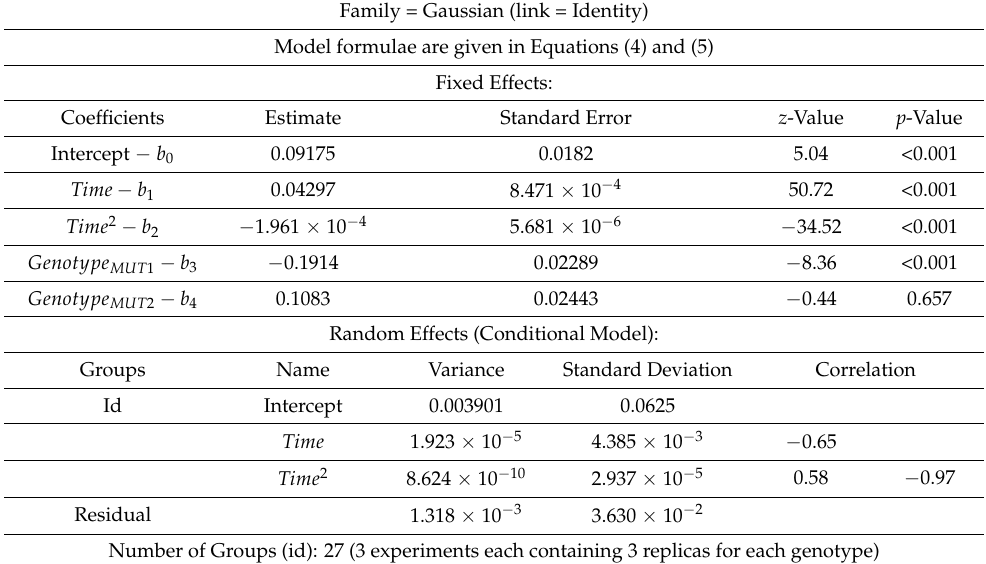
Table 1. Linear mixed model for chlorophyll